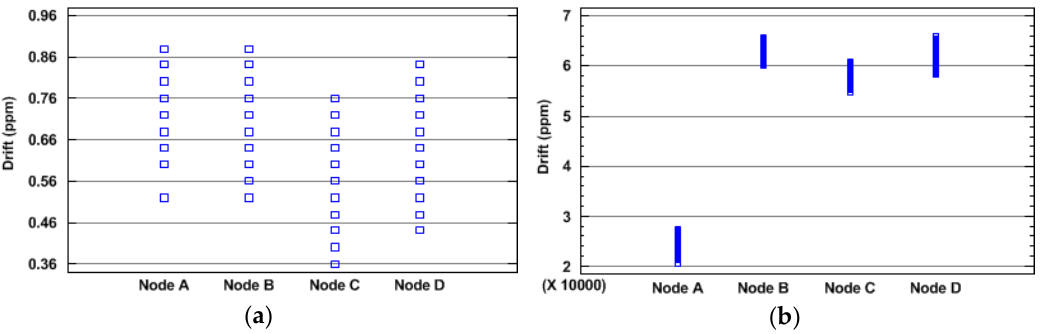
Figure 3. Scatter diagram of drift variation in four nodes ( a ) with a high quality clock source, and ( b ) with a low quality clock source.